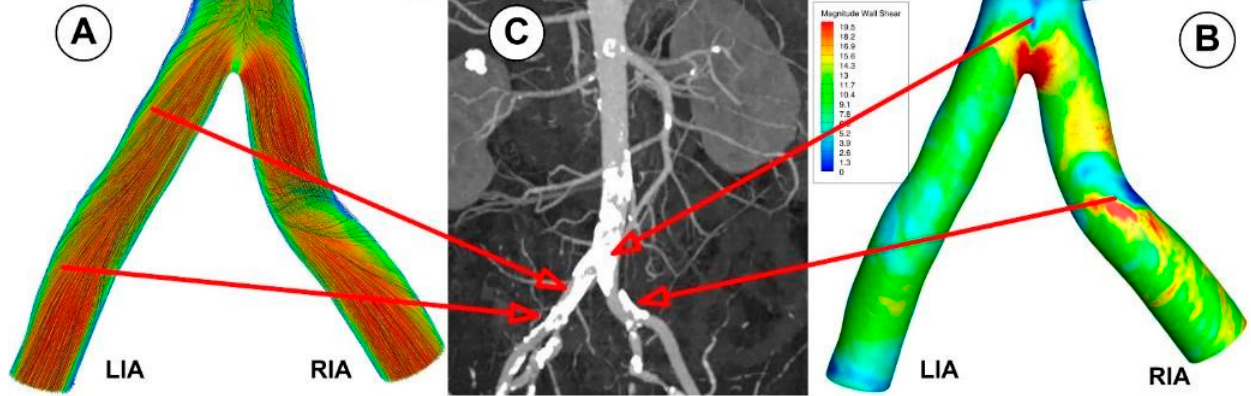
Figure 20. Correlation between WSS evolution obtained using numerical analysis ( A , B ), and disease location found during CTA investigation ( C ). CFD models estimate the hemodynamic markers (WSS) in the iliac artery bifurcation.